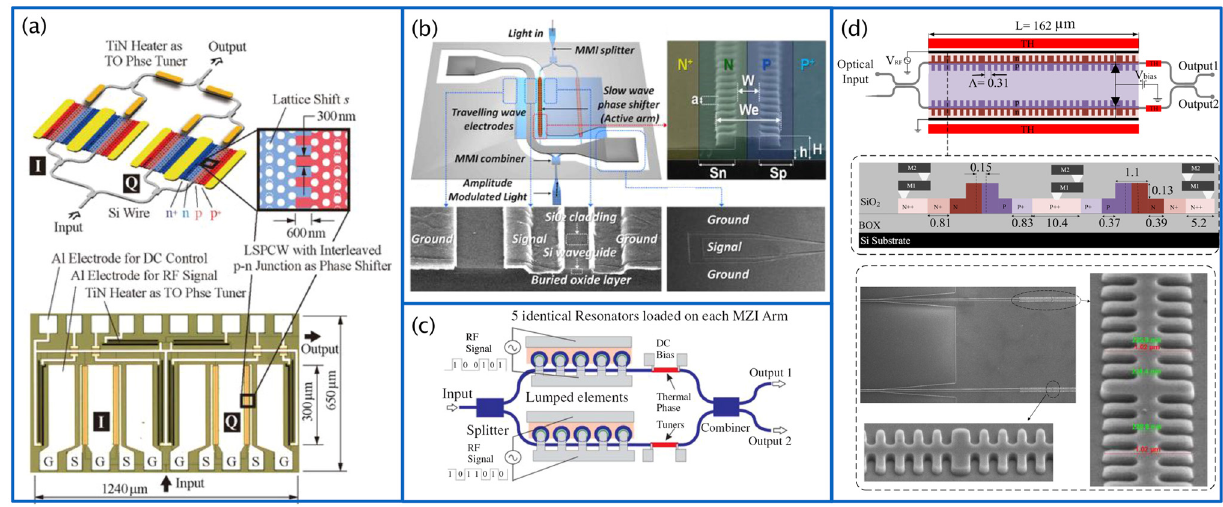
Figure 13: Slow light modulators. (a) IQ modulator in 2D photonic crystals with interleaved p - n junctions [174]; (b) Bragg grating modulator working in the slow-light region (i.e.,atthephotonicbandedge)[177];(c)MZMmodulatorusingslow-lightwaveguidesincascadedovercoupledmicroringresonators[172];(d) MZM modulator using cascaded phased-shifted Bragg gratings (i.e., coupled 1D photonic crystals) [173]. MZM, Mach-Zehnder